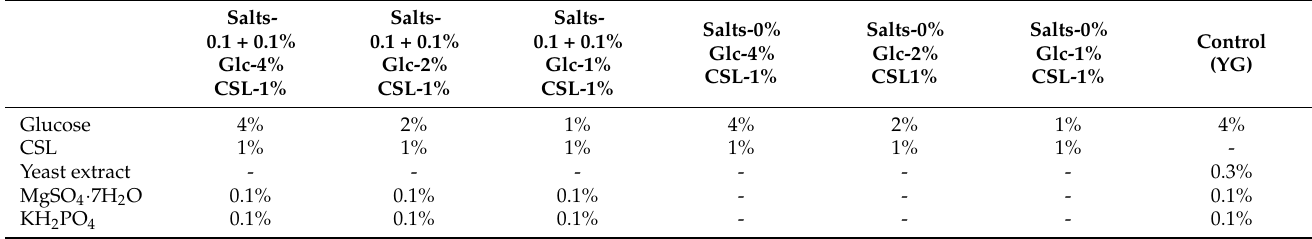
Table 3. Compositions of the CSL-1% media with reduced concentrations of glucose and inorganic salts. All media were adjusted to a pH of 5.5 ± 0.1.